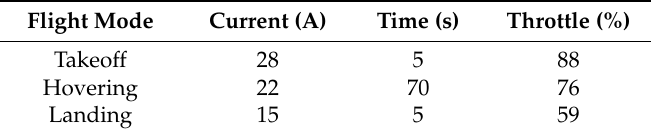
Figure 7. Current and voltage profile of unmanned aerial vehicles (UAV). Table 2. Current consumption during UAV flight.